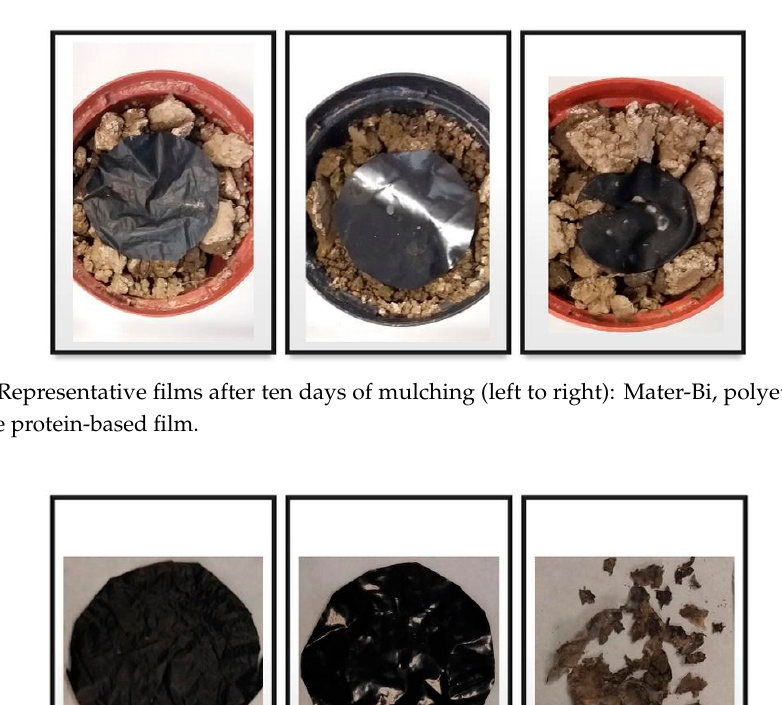
Figure 3. Representative films after being buried for twelve days (left to right): Mater-Bi, polyethylene, the innovative protein-based film.